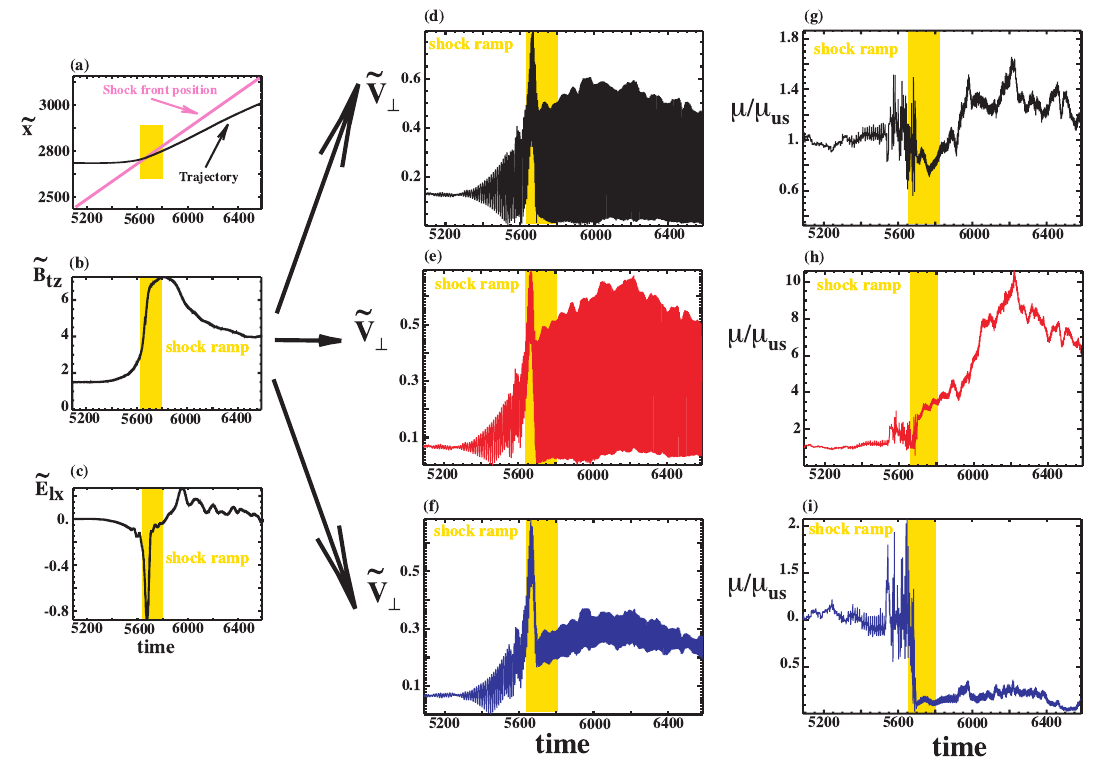
Fig. 3. Main characteristics versus time of selected electrons illustrating the three different types of transmitted electron populations (test particles simulation). All particles see the same macroscopic fields and have roughly the same trajectory. (a) x -coordinate of the particles (thin black line) and mean x -position of the shock front (thick pink line); (b) and (c) time history of the e B tz and e E lx fields seen by the different electrons. (d) to (f) and (g) to (i) show the time history of the perpendicular velocity and of the momentum ratio µ/µ us respectively, where µ = mv 2 ⊥ / 2 B and B is the local magnetic field seen by the particle. Black (panels d, g), red (panels e, h) and blue (panels f, i) colored plots are used in order to identify the so-called adiabatic, over-adiabatic and under-adiabatic electrons respectively defined by µ ds /µ us ≈ 1 ,> 1 ,< 1 ( µ us and µ ds are, respectively, the upstream and the downstream value of the magnetic